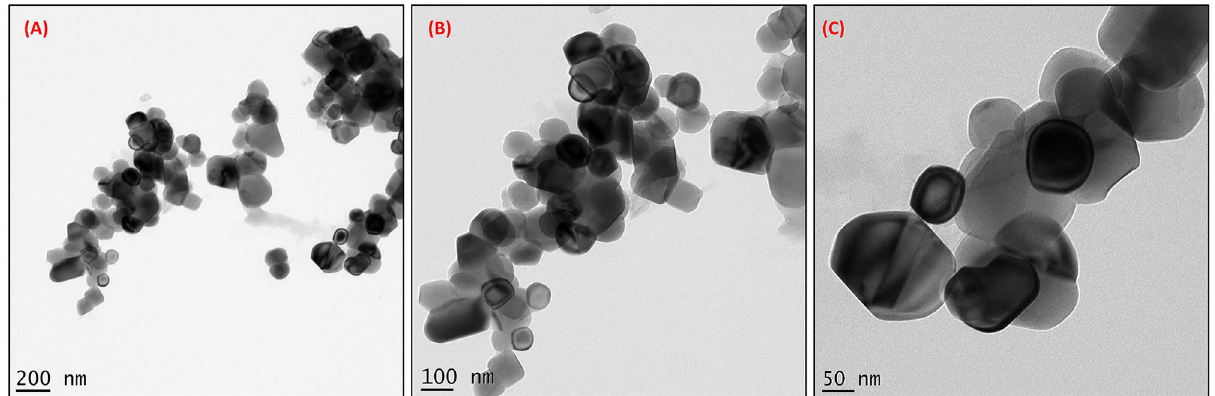
Figure 3. Different magnification of rapid synthesized SeNPs HR-TEM images ( A ) 200 nm, ( B ) 100 nm, ( C ) 50 nm.